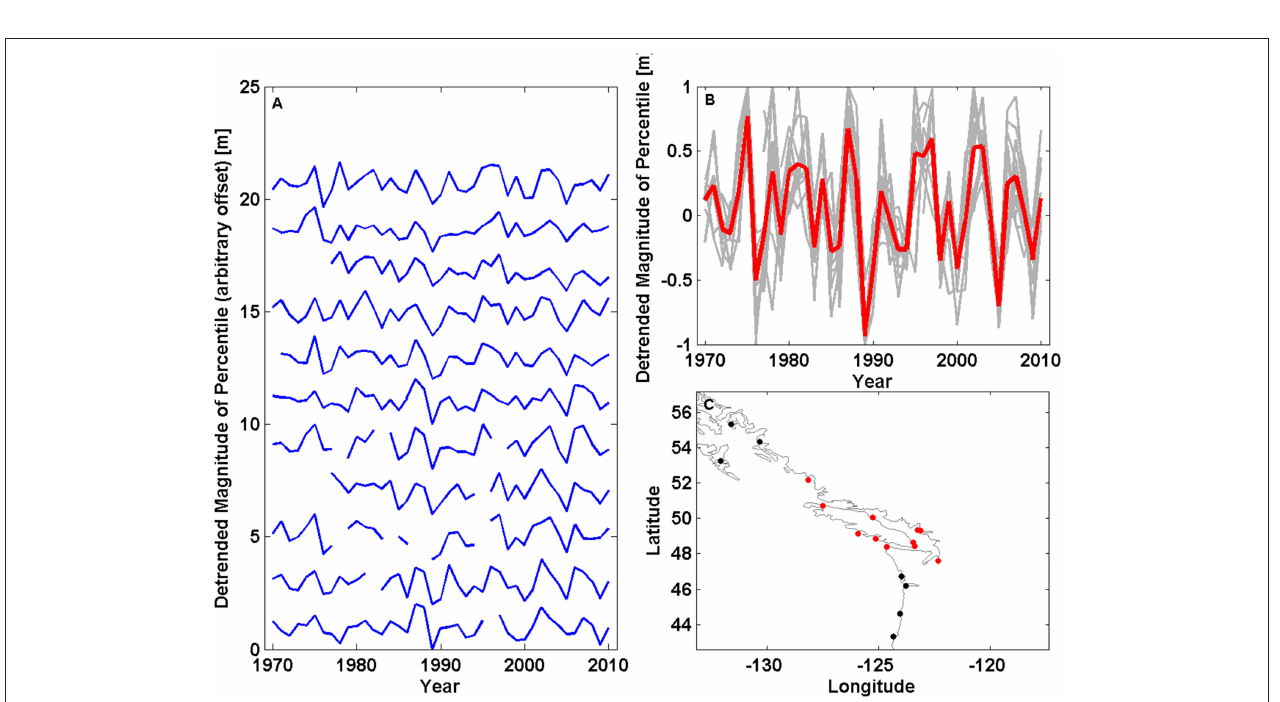
FIGURE 9 | Creation of regional skew surge index for the north-east Pacific. (A) The de-trended time series of the 99th percentile for each site from north to south (see Table 1 for site ID), (B) All the time-series with the mean of all sites plotted in red, and (C) the sites that are in this region highlighted in red.